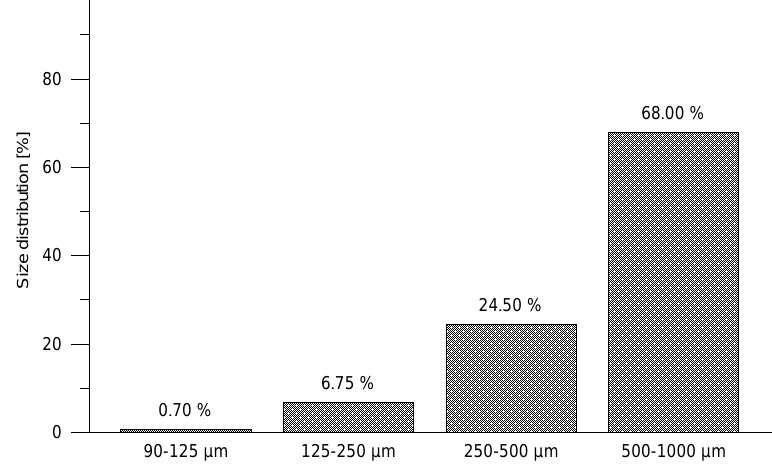
Figure 1. Powder—size